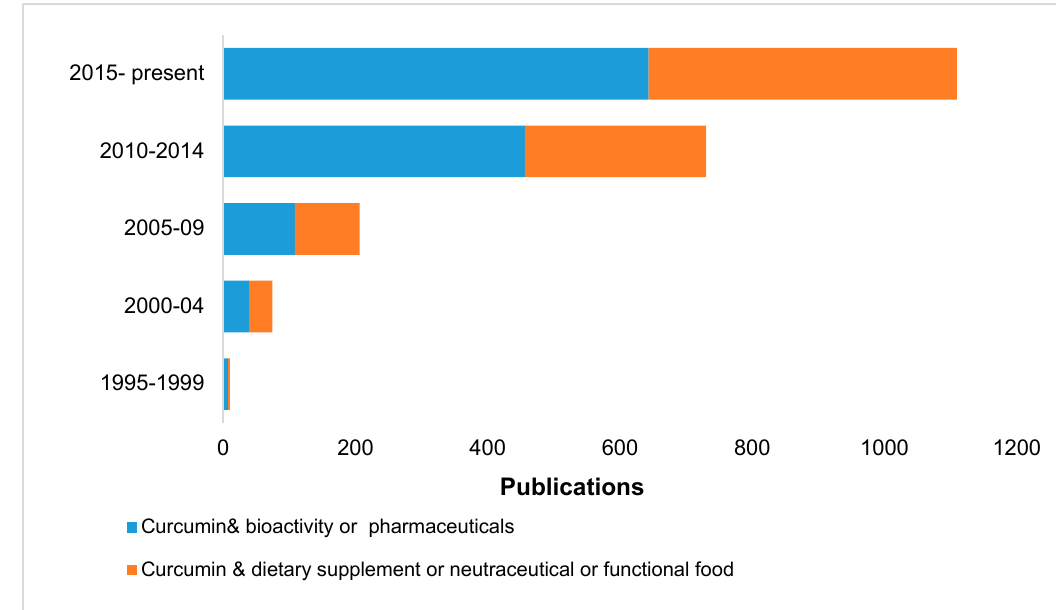
Figure 1. ( Top ) The number of publications published since 1995 on i) curcumin, ii) curcumin and clinical trials or animal studies, iii) curcumin and formulations, and iv) curcumin and analysis. ( Bottom ) v) curcumin and bioactivity or pharmaceuticals, and vi) curcumin and dietary supplement or nutraceutical or functional food.